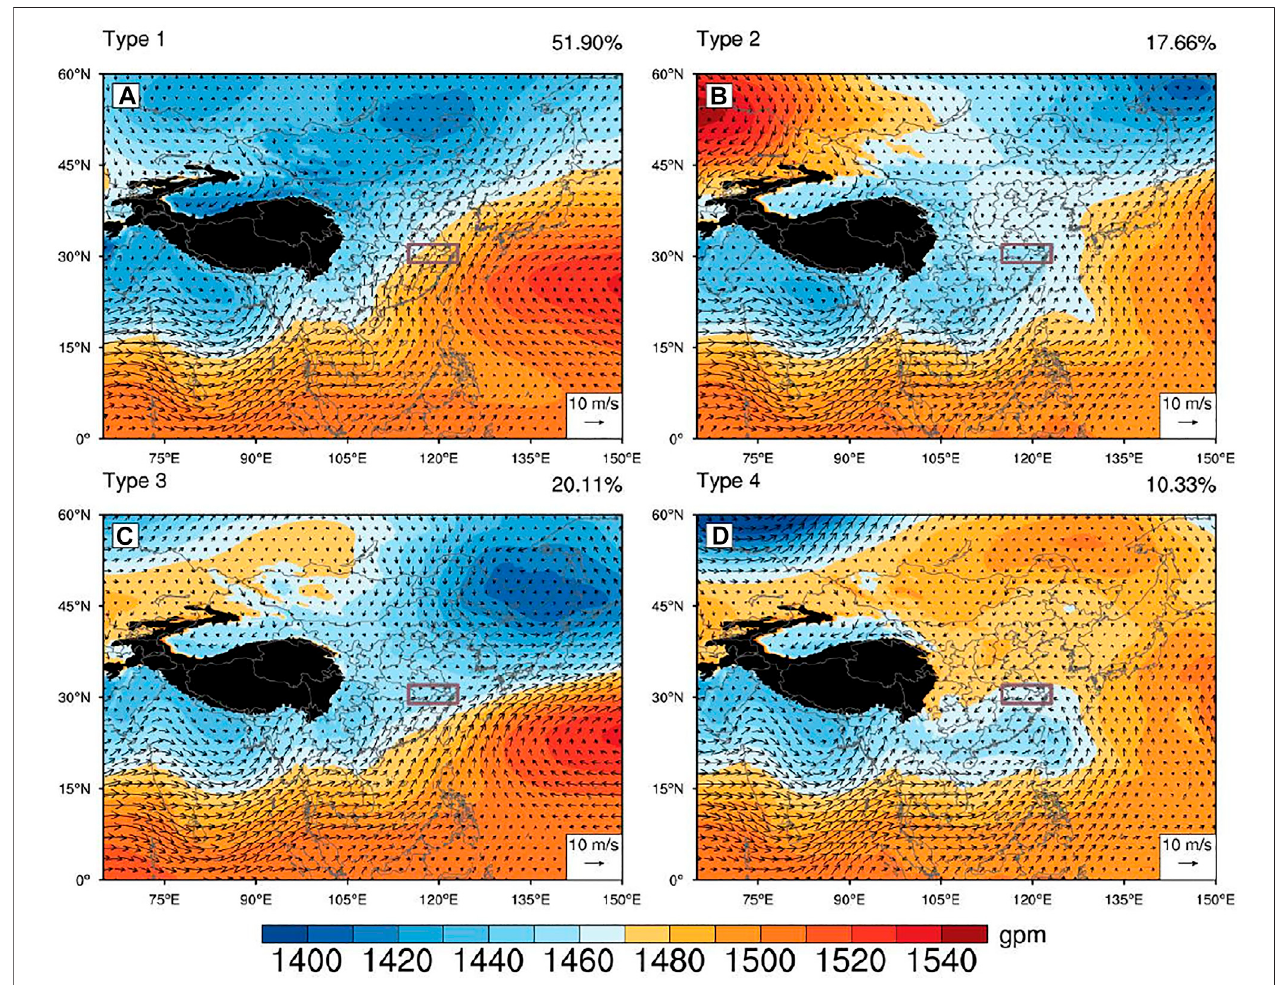
FIGURE3| The850-hPageopotentialheight fi eldandwind fi eldforfourSynopticWeatherPatterns(SWPs): (A) Type1, (B) Type2, (C) Type3,and (D) Type4.The purple box indicates the YRDUA region.